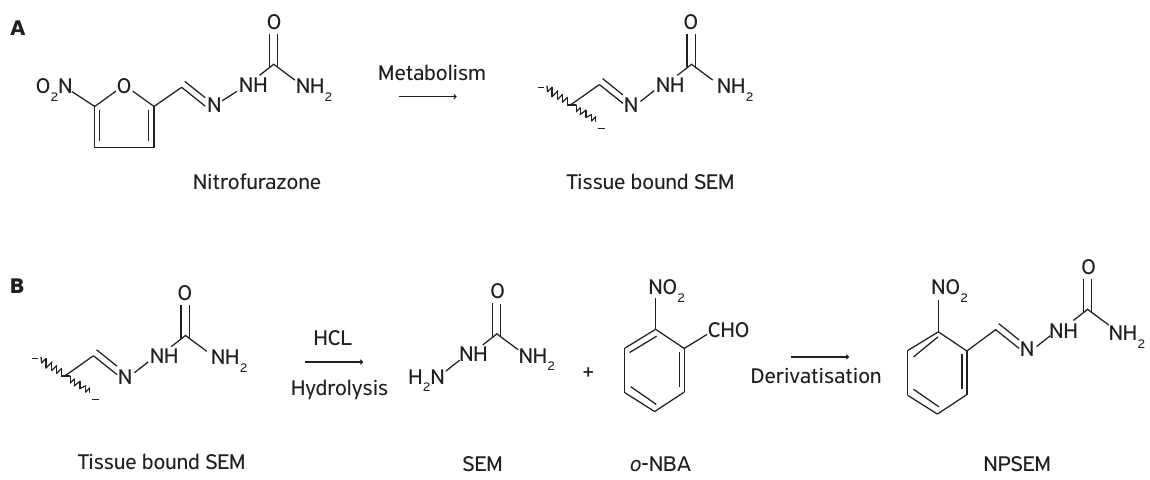
Figure 3. In vivo formation of tissue bound SEM (A). Release of bound SEM under mildly acidic conditions followed by SEM derivatisation to produce target analyte